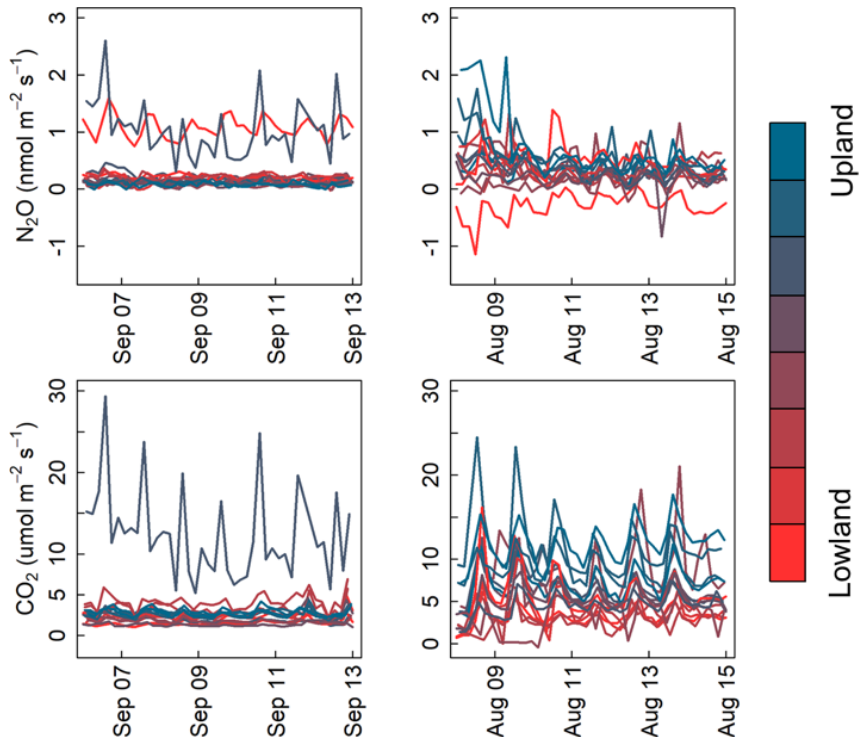
Figure 9. N 2 O and CO 2 flux time series shaded by plot topographic location over two 1-week periods in September 2017 and August 2018.